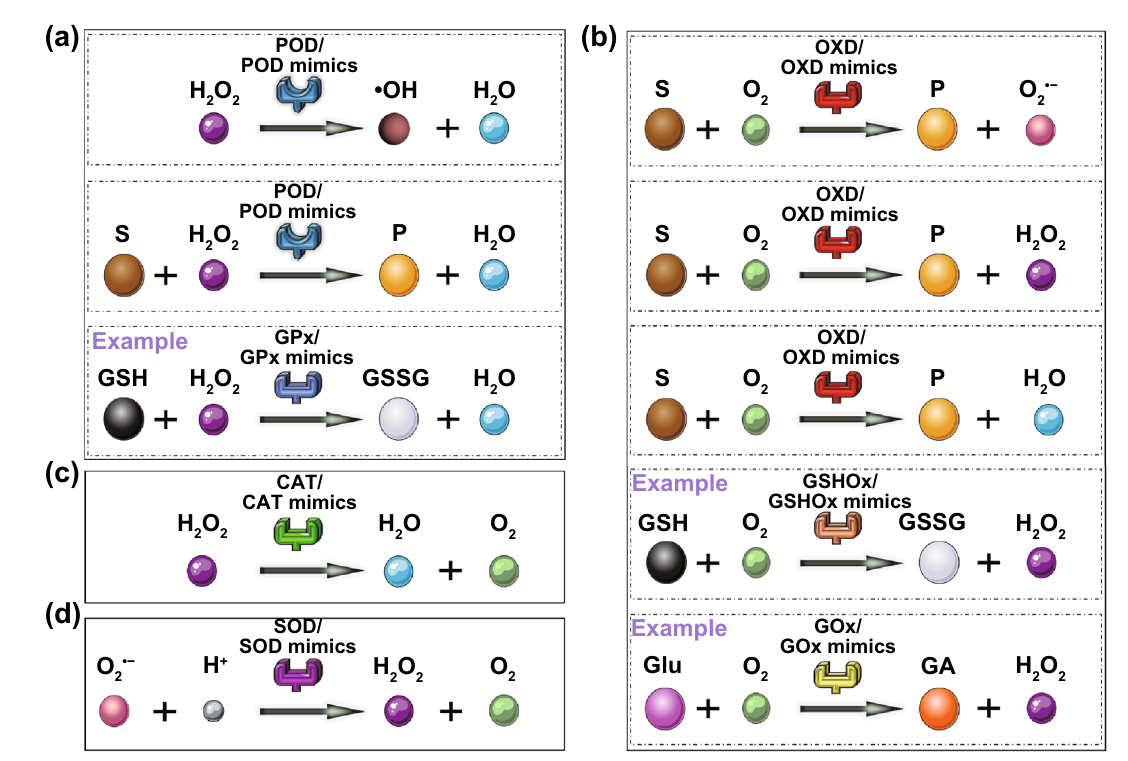
Fig. 2 Schematic presentation showing the catalysis reaction mediated by different oxidoreductases and their mimics including a POD/POD mimics and a typical kind of POD/POD mimics (glutathione peroxidase, GPx), b OXD/OXD mimics and two typical kinds of OXD/OXD mim- ics (glutathione oxidase, GSHOx; glucose oxidase, GOx), c CAT/CAT mimics, and d SOD/SOD mimics. The chemical species upon which enzymes act are termed substrates (S), and the molecules obtained from enzyme-catalyzed reactions are termed products (P). GSH, glutathione; GSSG, glutathione disulfide; Glu, glucose; GA, gluconic acid